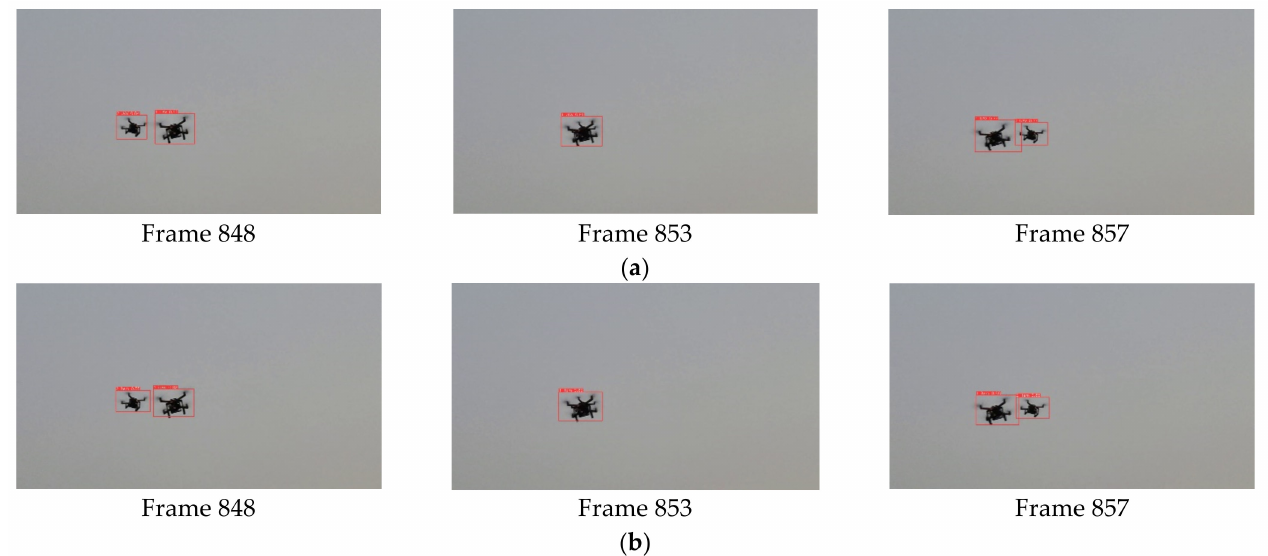
Figure 12. Algorithm tracking effect of UAVs in track cross occlusion. ( a ) YOLOv5 + Deepsort; ( b ) improved YOLOv5 +